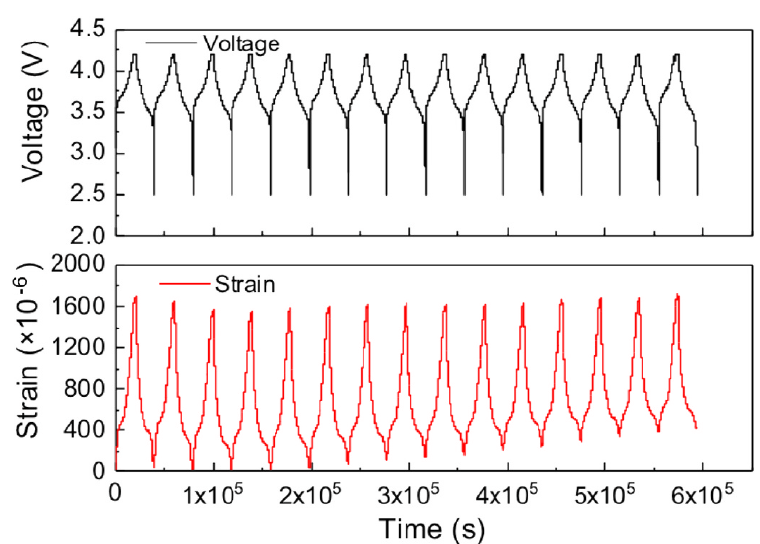
Figure 8. The cycle performance of the instrumented Li-ion cell and the evolution in-operando circumferential internal strain during the first 15 cycles. It is evident that a certain part of the strain is not recovered after the discharge. Reprinted with permission from ref. [42]. Copyright